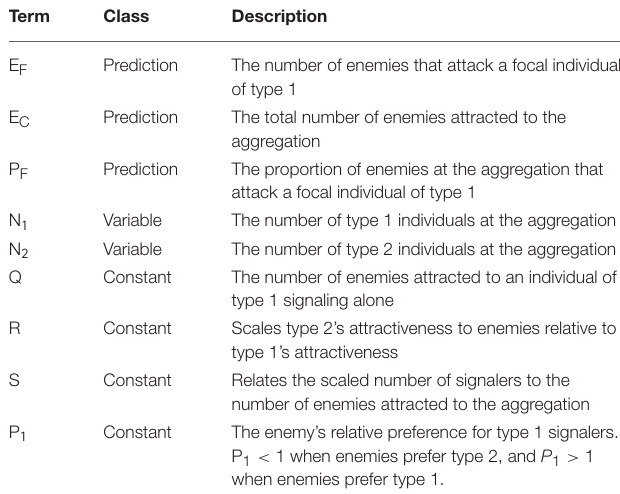
TABLE 1 | Model terminology and